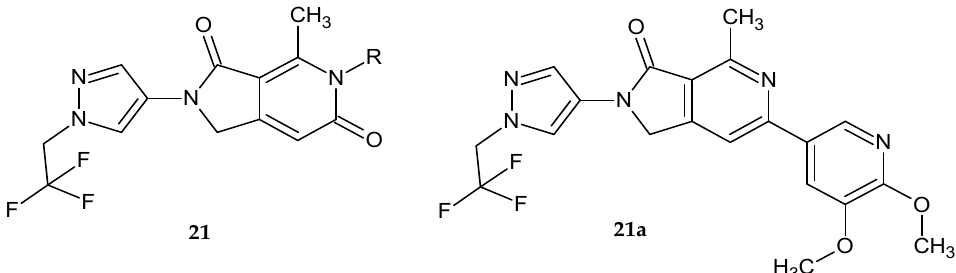
Figure 16. 4 ‐ Methyl ‐ 2 ‐ [1 ‐ (2,2,2, ‐ trifluoroethyl) ‐ 1 H ‐ pyrazol ‐ 4 ‐ yl] ‐ 1 H ‐ pyrrolo[3,4 ‐ c ]pyridin ‐ 3 ‐ one derivatives 21 and compound 21a as the potent inhibitor of PI3Ks.